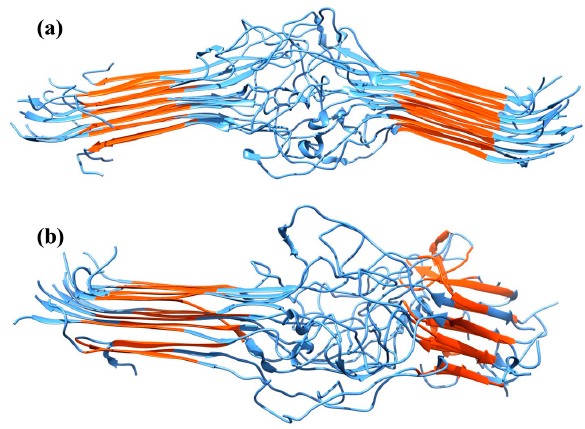
Figure 3. Representative TREX-MD structures at 300 K, with poly(Ala) region in red, rest in blue. ( a ) AP; ( b ) AA system. Table 2. Structural data of 300 K replica. Root-mean-square deviation (RMSD) in Å and angles in degrees. Secondary structural elements in the spacer regions (residues 82–107) are given as a percentage of all spacer residues; π -helices and bridges are not reported.